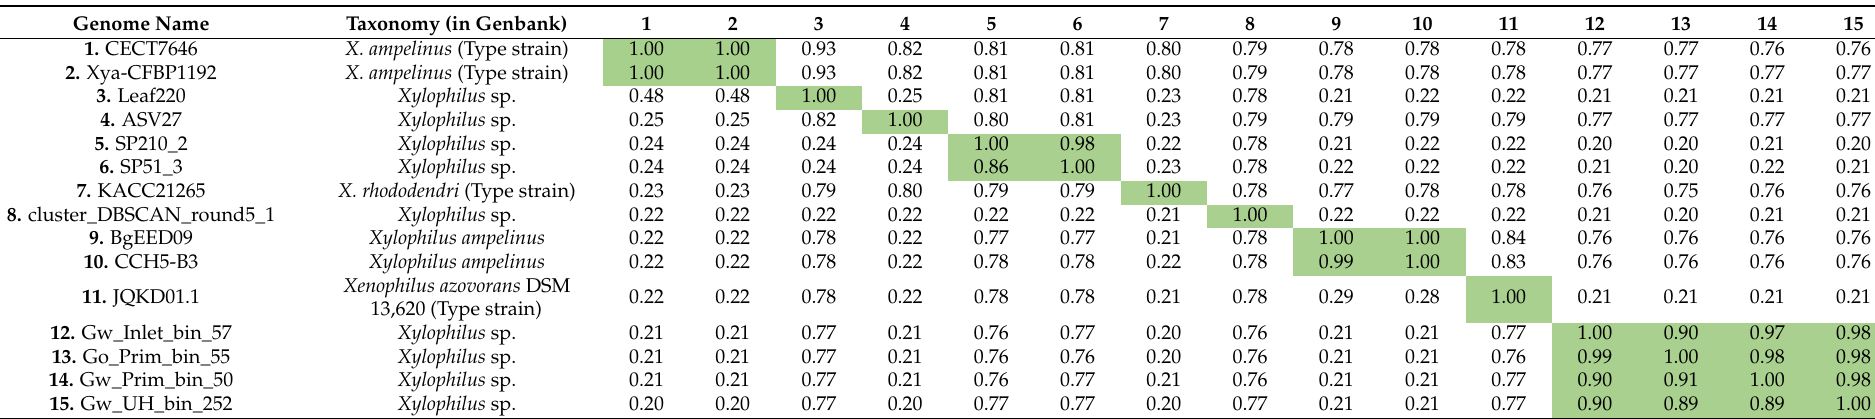
Table 4. ANIb (above diagonal) and dDDH (below diagonal) values, calculated respectively with pyani [33] and TYSG, formula d 4 [35]. Highlighted in green, the values above the 95% (for ANIb) or 70% (for dDDH) thresholds for bacterial species delineation. The numbers featured on top, correspond to the genome number on the left. CFBP 1192 T and CECT 7646 T are both equivalent of the same type strain of the species held in two different